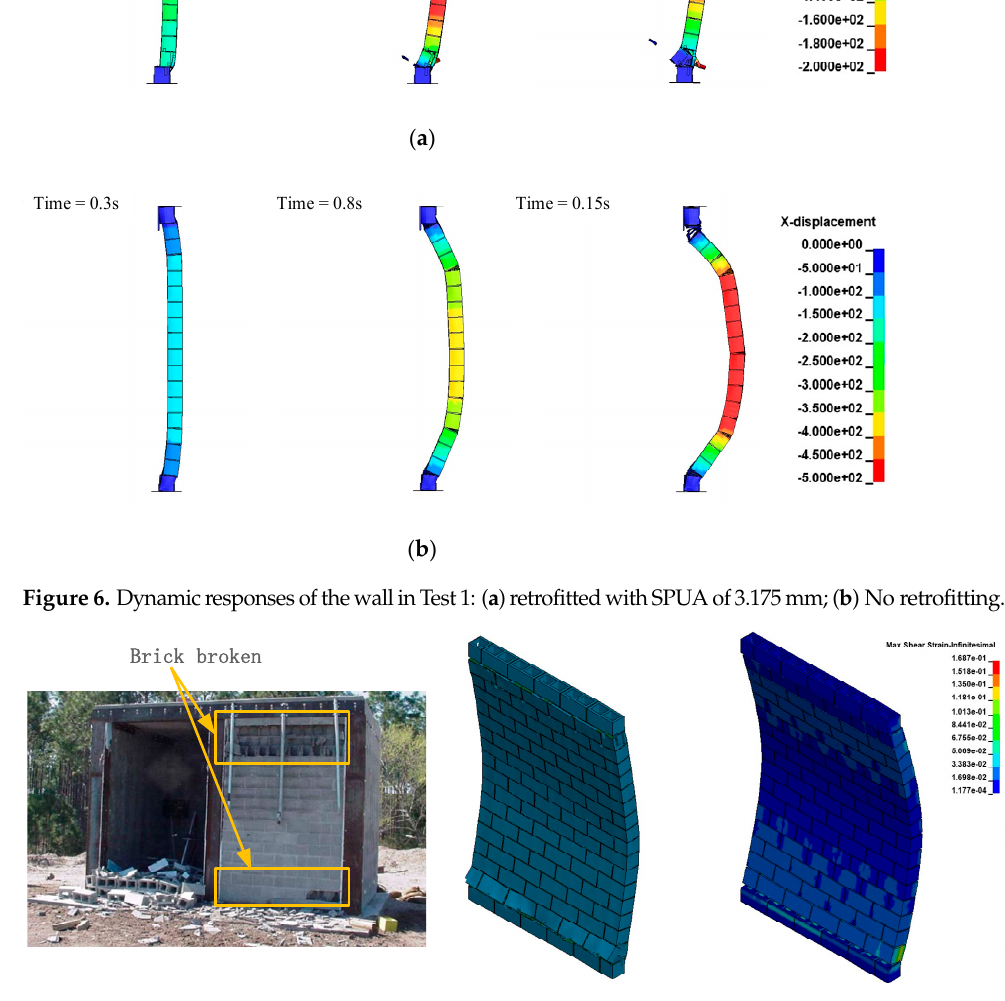
Figure 7. Damage of SPUA-retrofitted wall: ( a ) local damage; ( b ) simulated damage; ( c ) shear stress distribution.